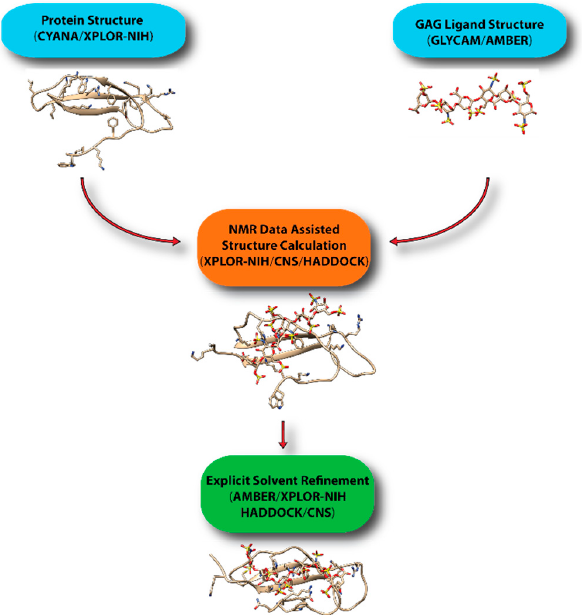
Figure 16. Common workflow in determining structures of protein-GAG complexes using sparse information. To ensure proper ring puckering and stereo chemistry, the initial ligand structure should be created with AMBER using the updated GLYCAM force field. After docking the ligand using experimental data in either XPLOR-NIH or HADDOCK/CNS, an explicit solvent refinement is highly desirable.